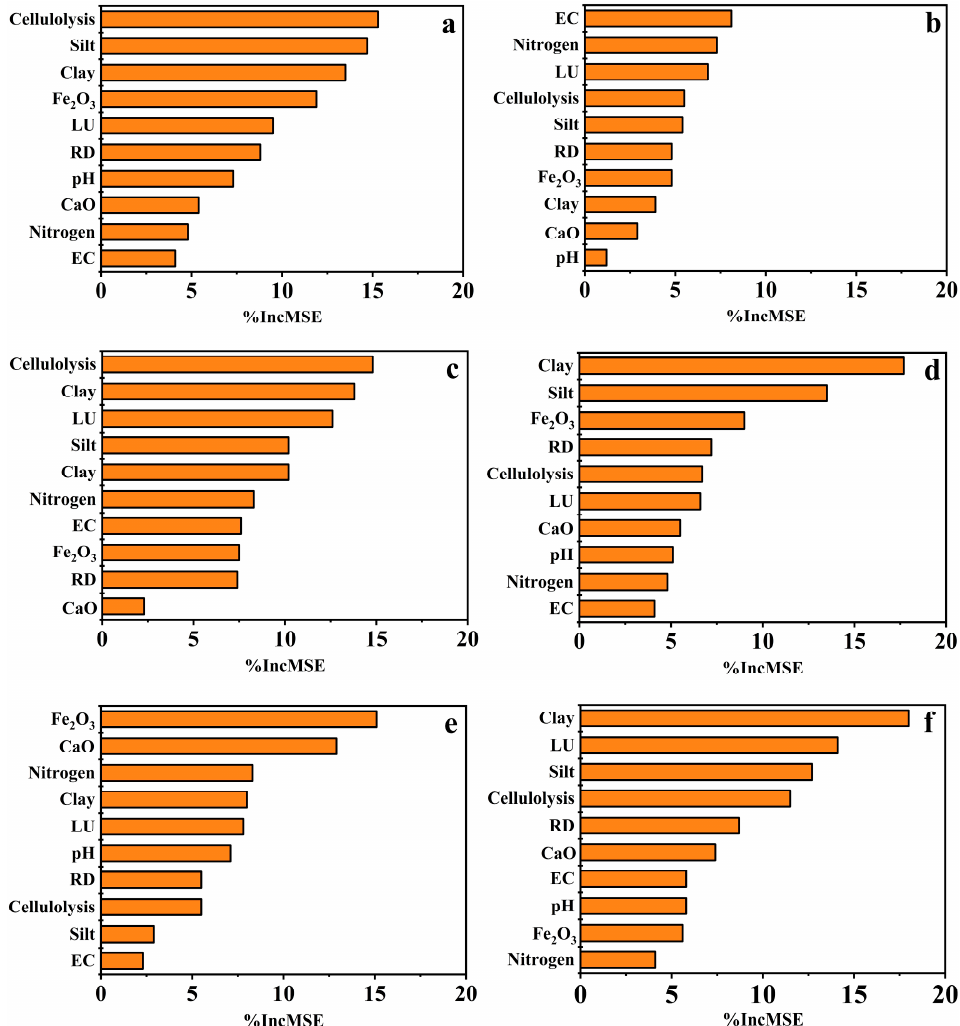
Figure 7. Relative importance of each predictor calculated by the random forest model for each nutrient index: ( a ) organic carbon; ( b ) C/N ratio; ( c ) total nitrogen; ( d ) C/P ratio; ( e ) total phosphorus; and ( f ) N/P ratio. EC, Electrical conductivity; LU, land use; RD, reclamation duration; nitrogen, nitrogen fi xation; % incMSE, increase in mean squared error.